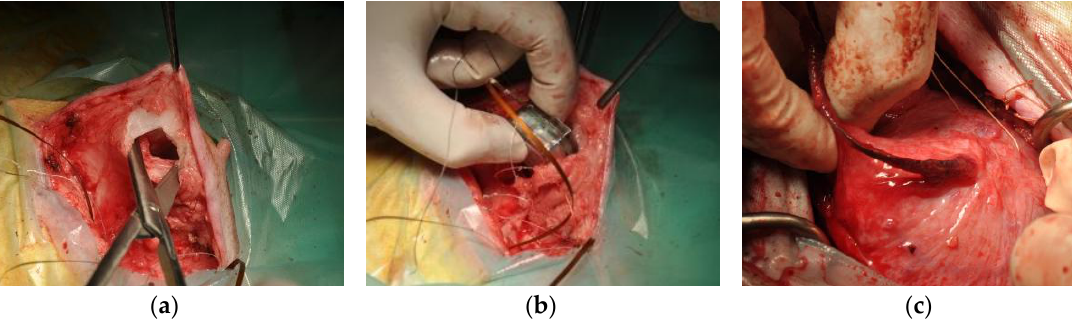
Figure 3. Several preliminary results showing feasibility of implantation procedure on a Göttingen minipig. ( a ) Fabrication of a pocket in the fat tissue for locating the communication system; ( b ) Insertion of the communication system into the fat pocket ( c ) Submucosal position of a flexible dummy PCB on the bladder, after 5 weeks of